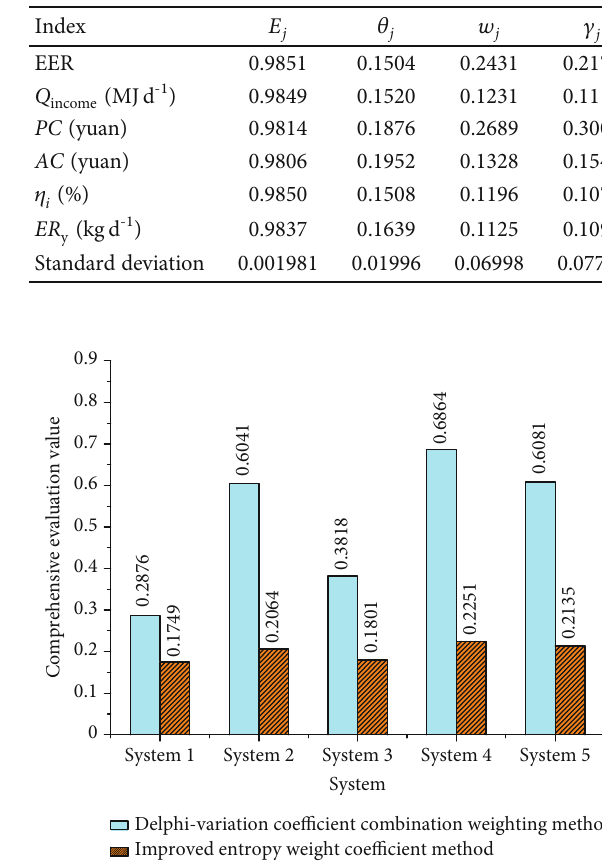
Figure 15: Comprehensive evaluation values of the di ff erent biogas heating